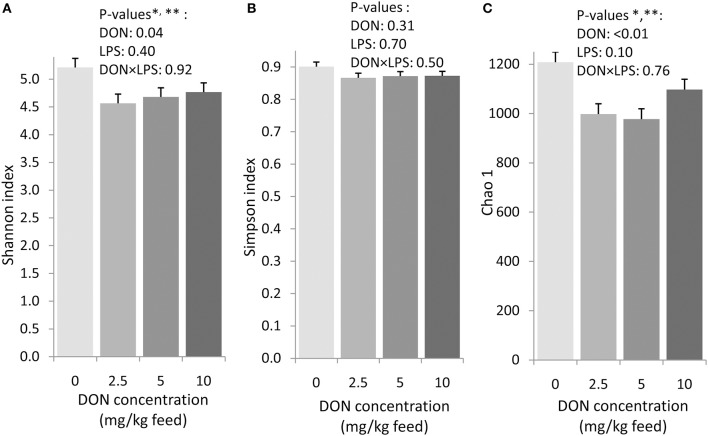
Shannon index (A), Simpson index (B), and Chao1 richness estimate (C) in cecal digesta of chickens fed diets with increasing levels of deoxynivalenol (DON; 0, 2.5, 5, or 10 mg DON/kg diet). Values are presented as least squares means ± standard error of the mean (SEM); n = 20 broilers per feeding group. Presented data include both animals with and without oral lipopolysaccharide challenge (LPS) 1 day prior to slaughter within the respective feeding group. * Contrast comparing the 0 DON with all DON groups (0 vs. DON): p < 0.05. ** Quadratic contrast: p < 0.05.